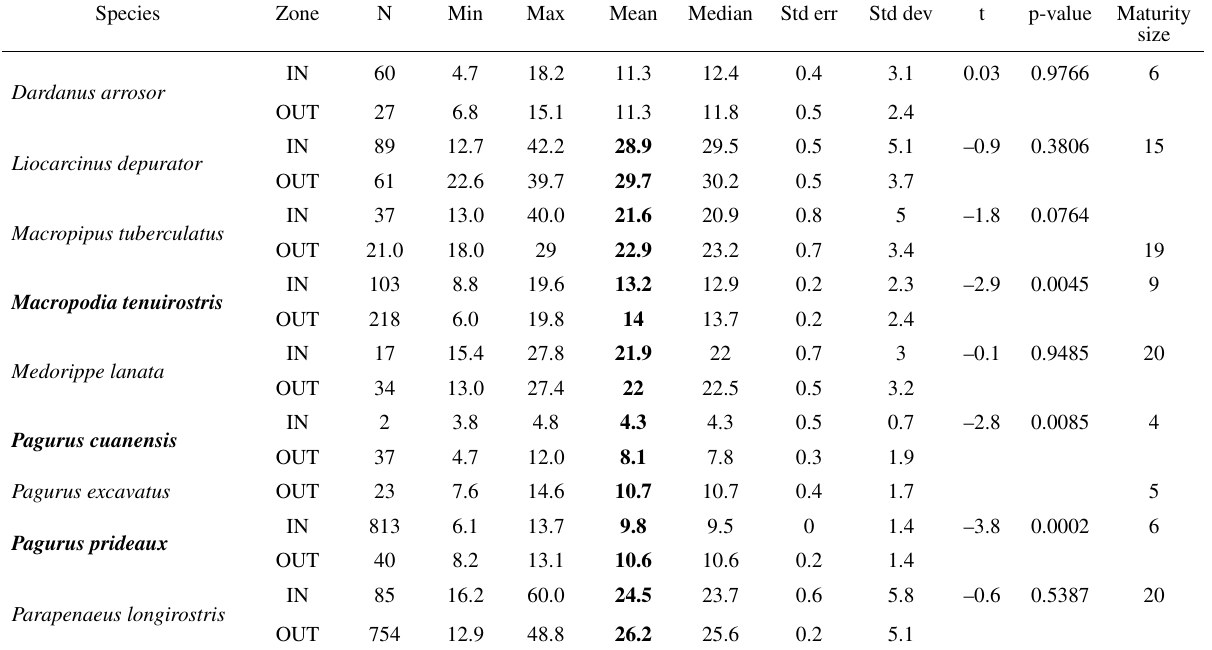
Table 5. – Size statistics by species and zone inside (IN) and outside (OUT) the no-take area, those species with n>30 individuals measured. Species in bold showed significant differences in mean size between zones. N, number of individuals measured; Min, Max, Mean, Median, minimum, maximum, mean, median size; Std err, standard error of the mean; Std dev, Standard deviation; t, Student’s t value; p, probability of rejecting the null hypothesis. Sizes, as carapace length (shield length in hermit crabs), in mm for all species but L. depurator (carapace width), and size at maturity in mm. Mean sizes larger than maturity size (from Table 2) are shown in